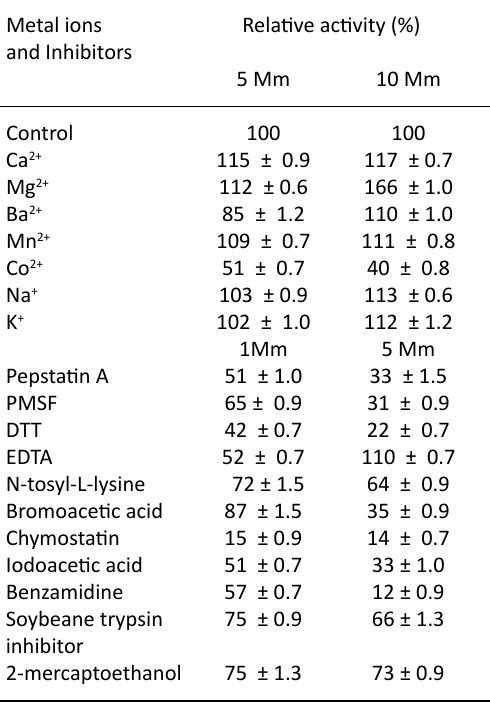
Table 1. Effect of metal ions and inhibitors on keratinolytic activity of Azotobacter chroococcum B4 Metal ions Relative activity